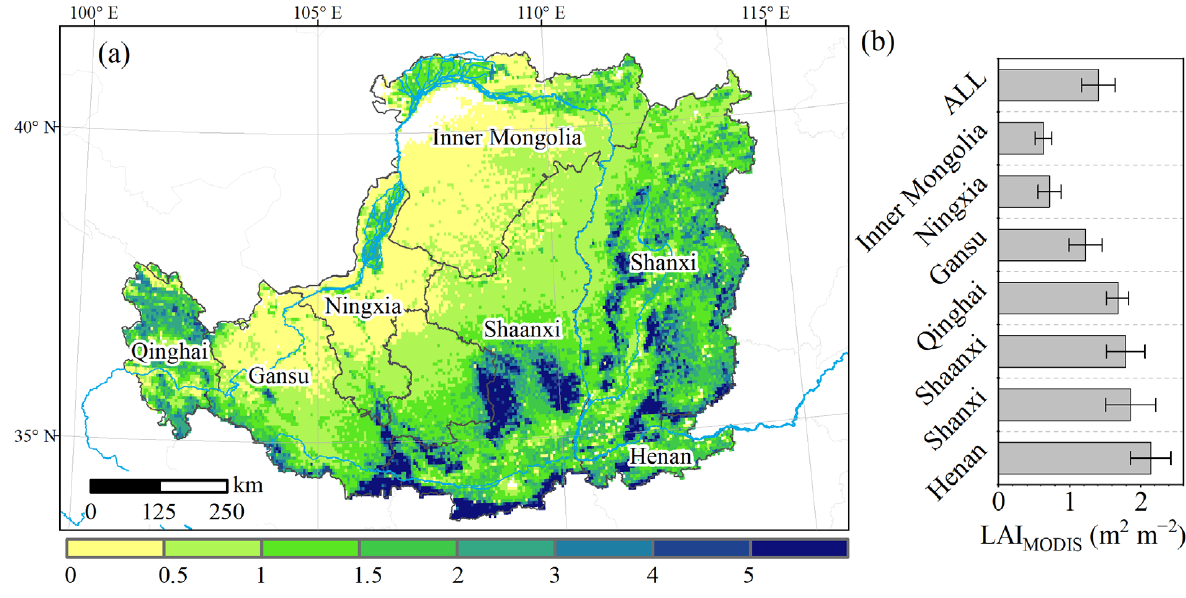
Figure 2. ( a ) The spatial pattern and ( b ) average values for each province of MODIS LAI on the Loess Plateau.